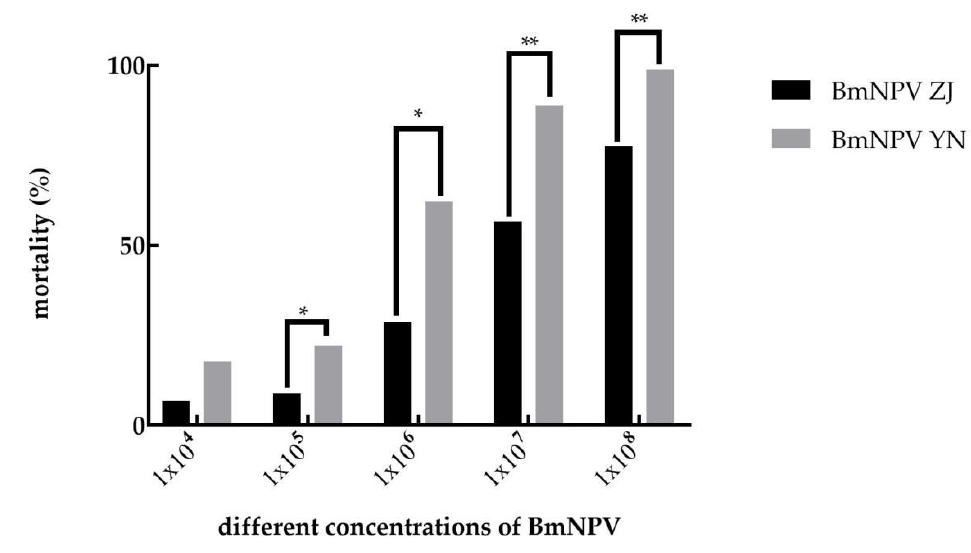
Figure 1. A comparison of the pathogenicities of different concentrations of the two BmNPV strains against Baiyu larvae. Note: “*” represents p < 0.05; “**” represents p < 0.01.